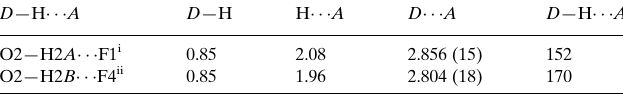
Hydrogen-bond geometry (A˚ , (cid:4)